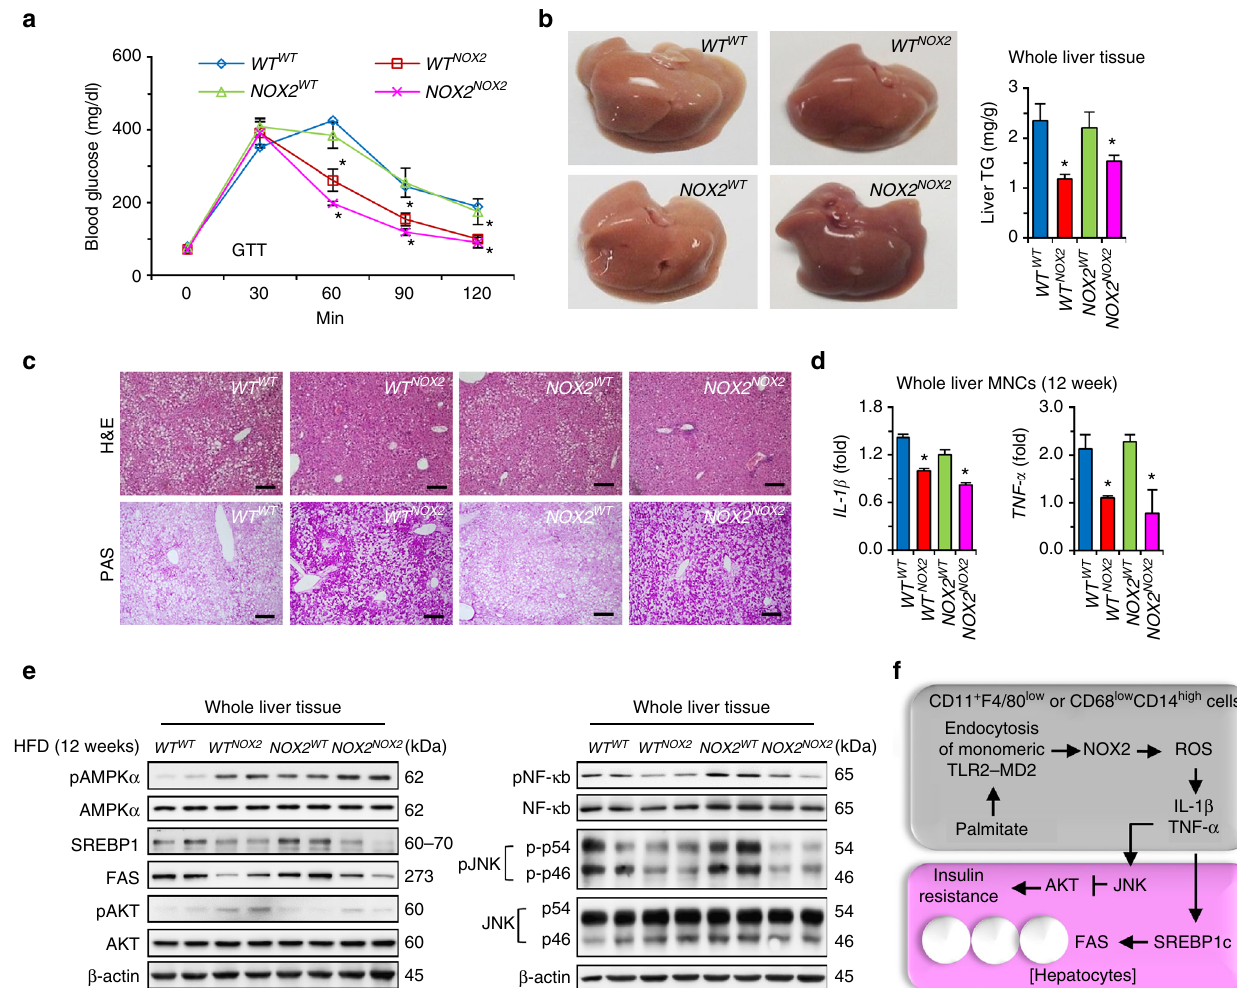
Fig. 8 NOX2-de fi cient bone marrow transplantation attenuates high-fat diet-induced hepatic steatosis in mice. After reciprocal bone marrow transplantation between WT and Nox2 KO mice, mice were fed a high-fat diet for 12 weeks. a GTT was performed after 16 h fasting. b Liver gross fi ndings and hepatic contents of TG were assessed. c Liver sections were stained with H&E (upper panels) and PAS (lower panels). Bar = 100 μ m. d Isolated liver MNCs were subjected to qRT – PCR analyses. e Whole liver tissues were subjected to Western blottings. f Schematic diagram of NOX2-mediated ROS generation through endocytosis of monomeric TLR4 – MD2 complex in non-resident macrophages by palmitate and its involvement in the pathogenesis of hepatic steatosis and insulin resistance. Data are representative of two independent experiments using 5 mice per group. Data are expressed as the mean